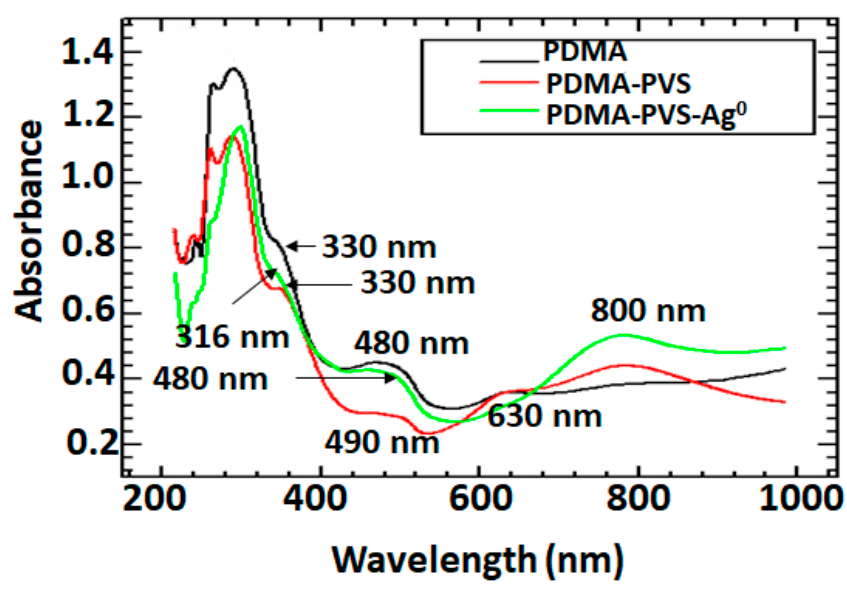
Figure 2. UV-vis absorbance spectra of PDMA (black line), PDMA–PVS (red line) and PDMA–PVS- Ag 0 (green line).